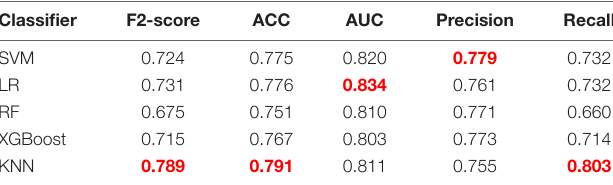
The best results for each specified classifier are highlighted in bold red. TABLE 2 | Comparison of the results of different classifiers based on the sigmoid feature set. Classifier Recall